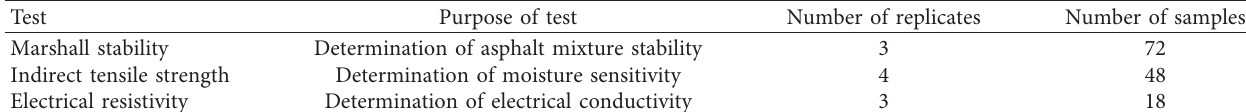
Table 4: Types and replicate numbers of the tests used in this